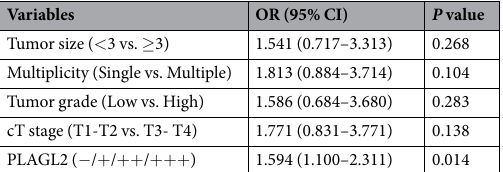
Table 5. Multivariable analysis of clinicopathological features for association with lymph node metastasis of BUC.